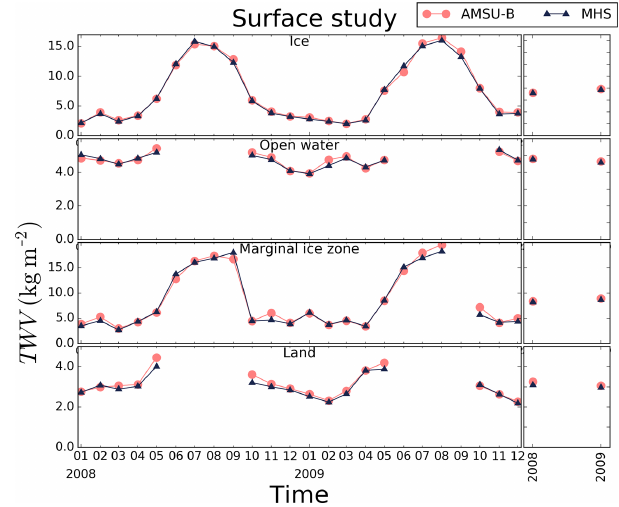
Figure 3. Monthly and yearly means for 2008 and 2009 of the AMSU-B (pink circles) and MHS (blue triangles). TWV retrieval over the locations shown in Fig. 2.